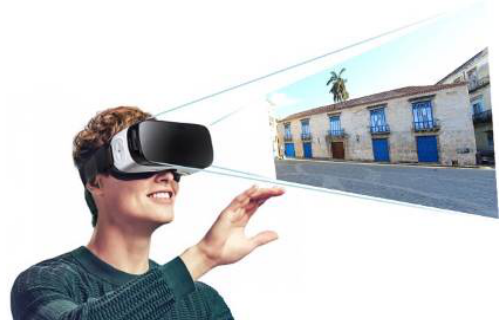
Figure 17. Example of an application of aumented reality